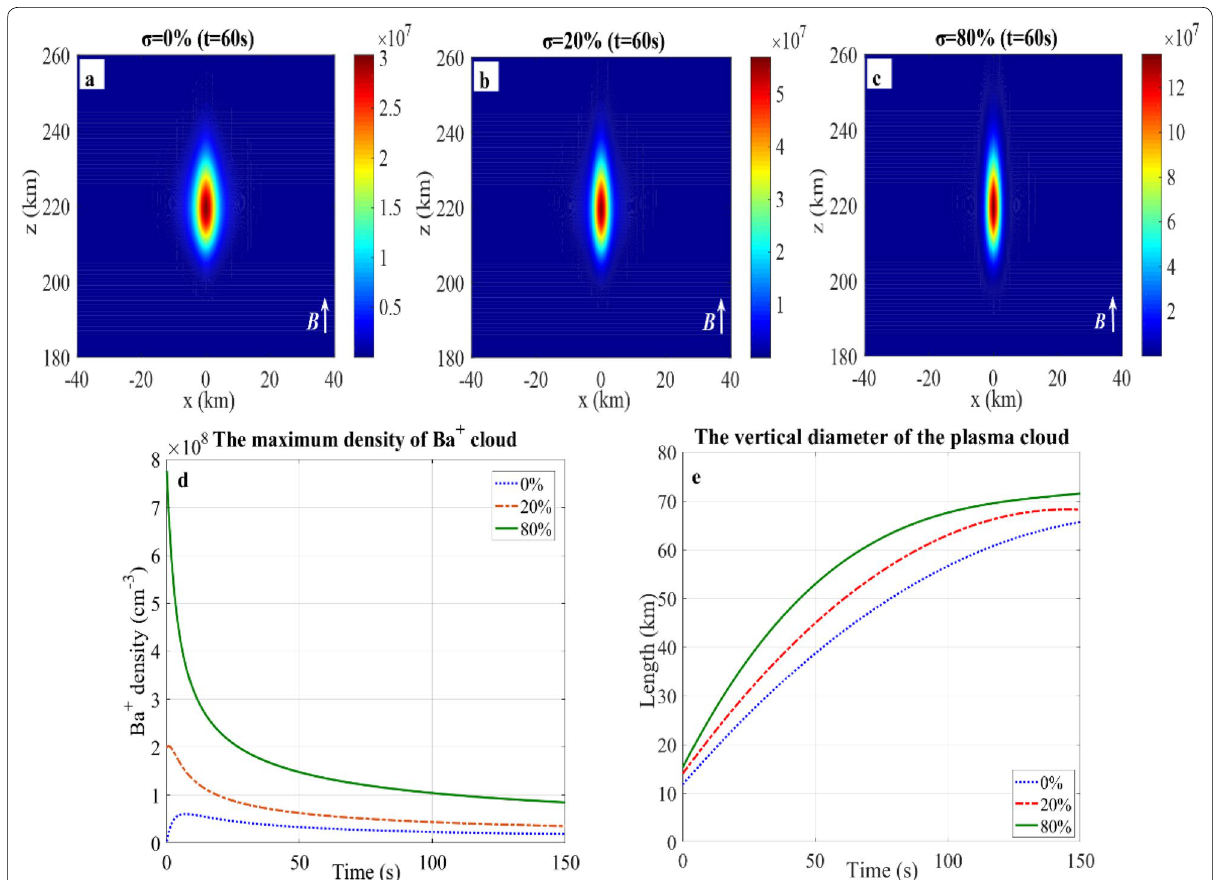
Fig. 6 The density distribution of Ba + clouds in the x – z plane (at t 60 s) after 10 kg Ba release at 220 km, with initial ionization rates ( σ ) of 0%, 20% = and 80% ( a , b , c ), the maximum density of the Ba + cloud changes with time ( d ), and the vertical diameter of the generated plasma cloud changes with time ( e ). Note that the location where the barium ion number density is 1/e of the peak density is defined as the plasma cloud boundary, and the vertical diameter of the ionosphere hole is determined